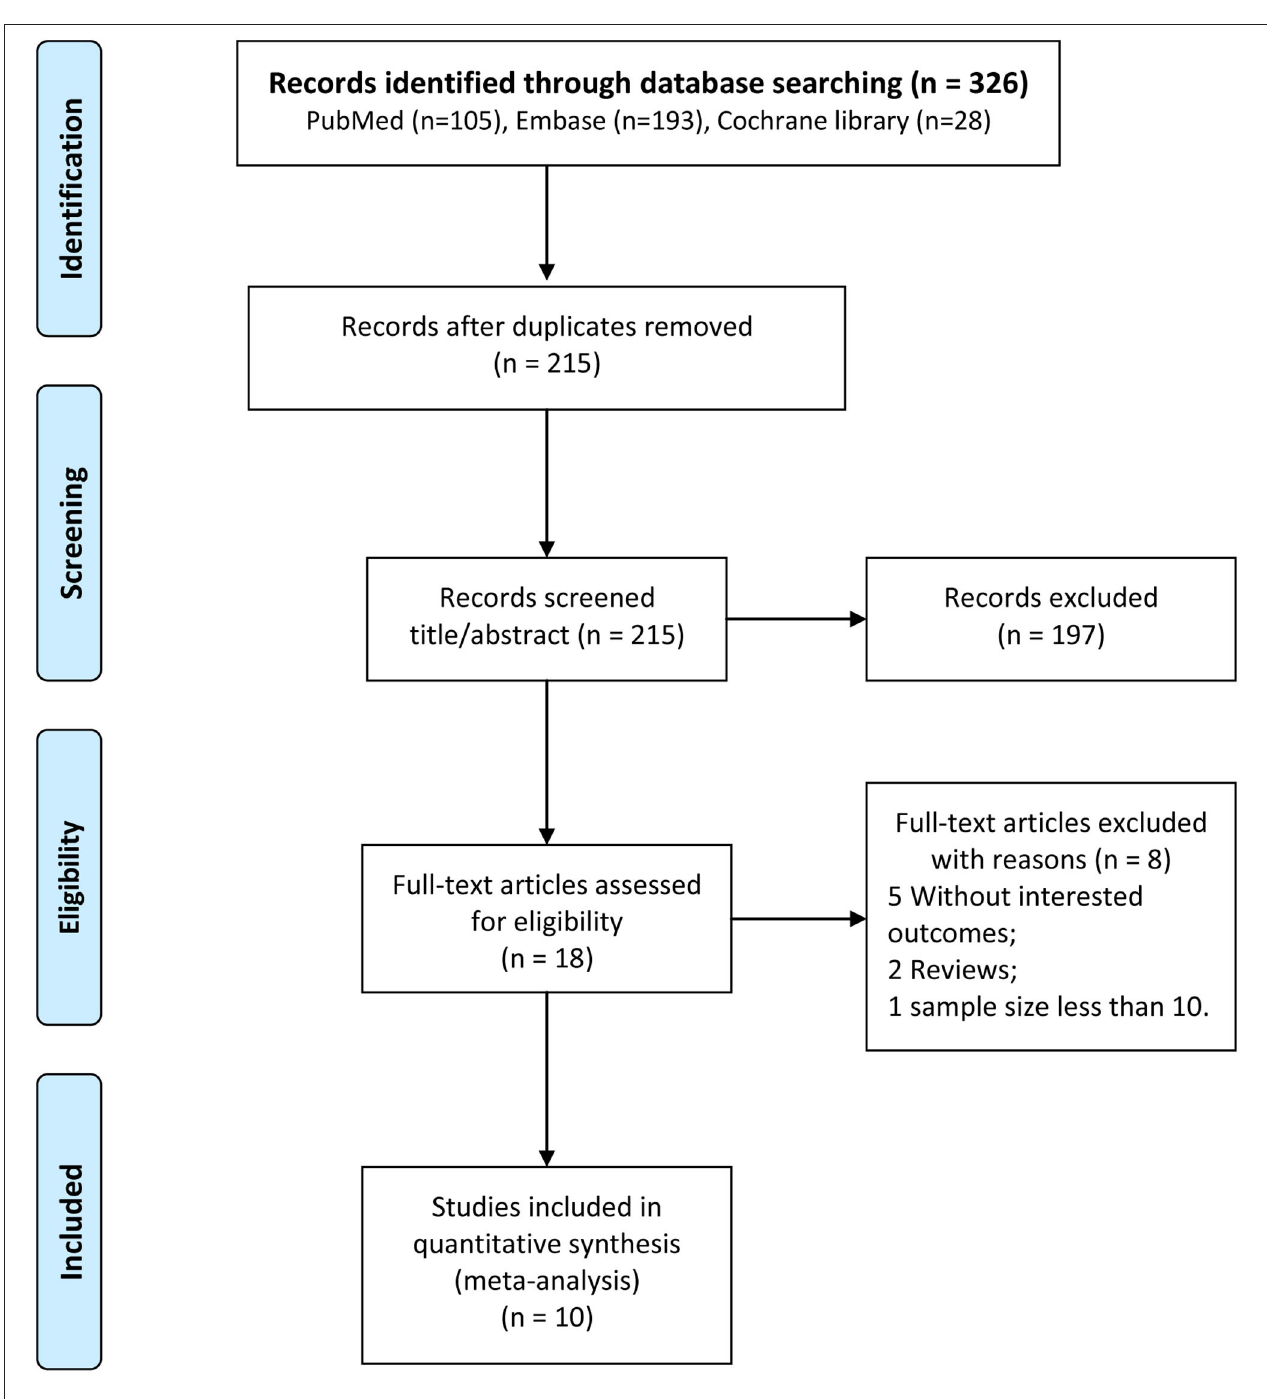
FIGURE 1 | Flowchart of study